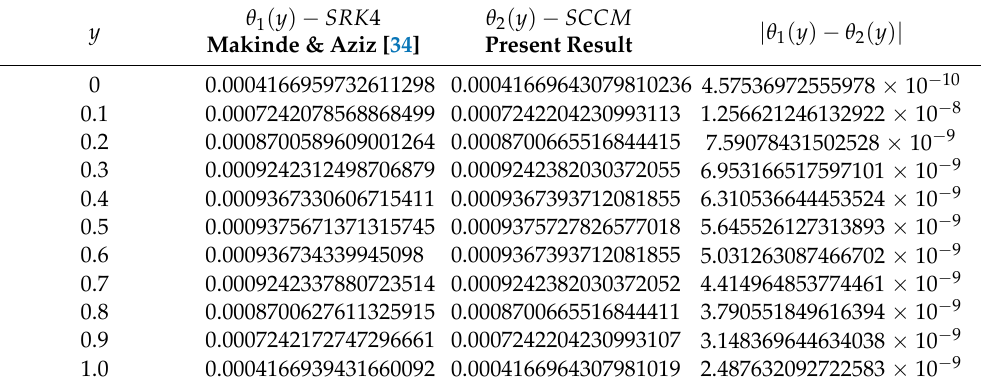
Table 6. Validation with previous result when Bi 1 = Bi 2 = 10, Gr = 0 = γ = η , α = 0.1